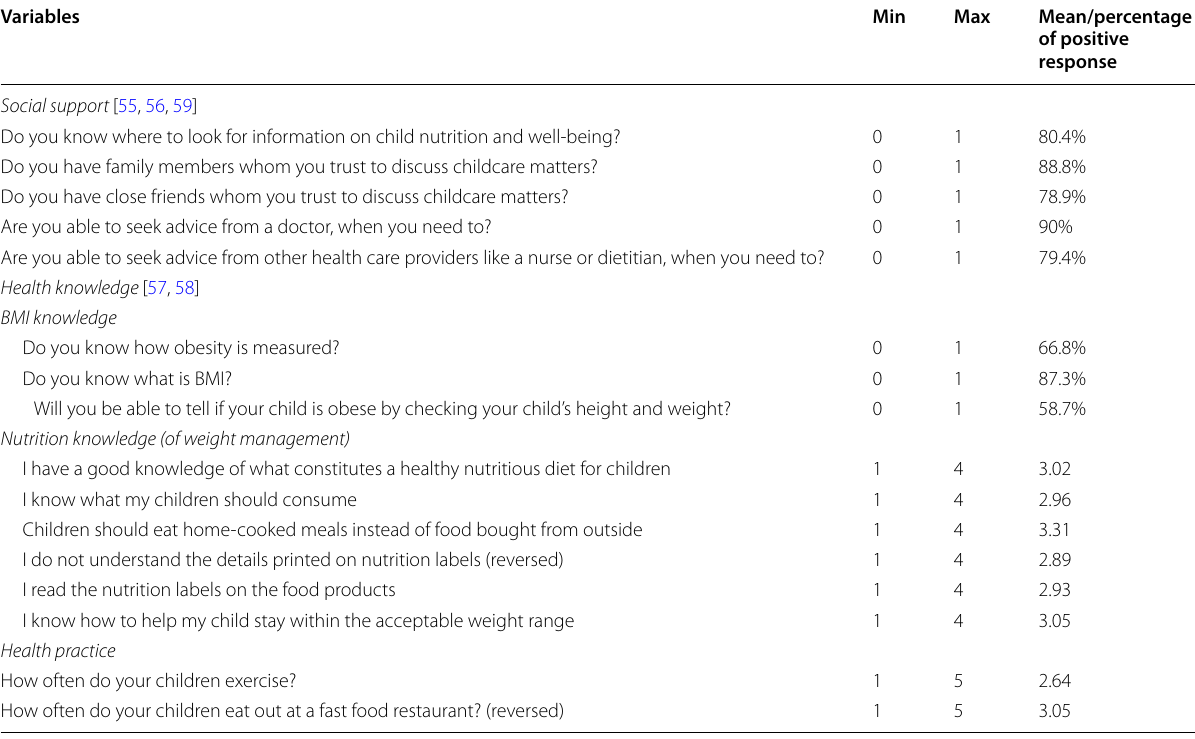
Table 2 Measurement scale of social support, health knowledge, and health practices